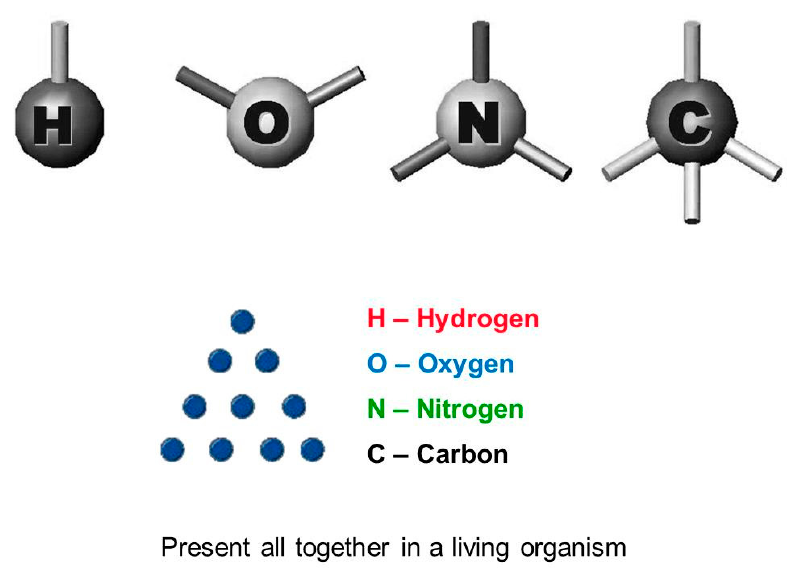
Figure 5. The basic constituents of living matter. The world we know is made up of 92 chemical elements, 81 of which are stable. Living matter uses only about 26–30 of these elements, but 99% of it consists of only four “bioelements”: carbon (C); nitrogen (N); oxygen (O); and hydrogen (H). The bioelements are able to form 4-3-2-1 bonds, respectively, and have a high tendency to get together and form complex molecules such as proteins and nucleic acids, which are different for every species. This means that at the basic level all living organisms are equal to each other, while in their complex forms they are different.